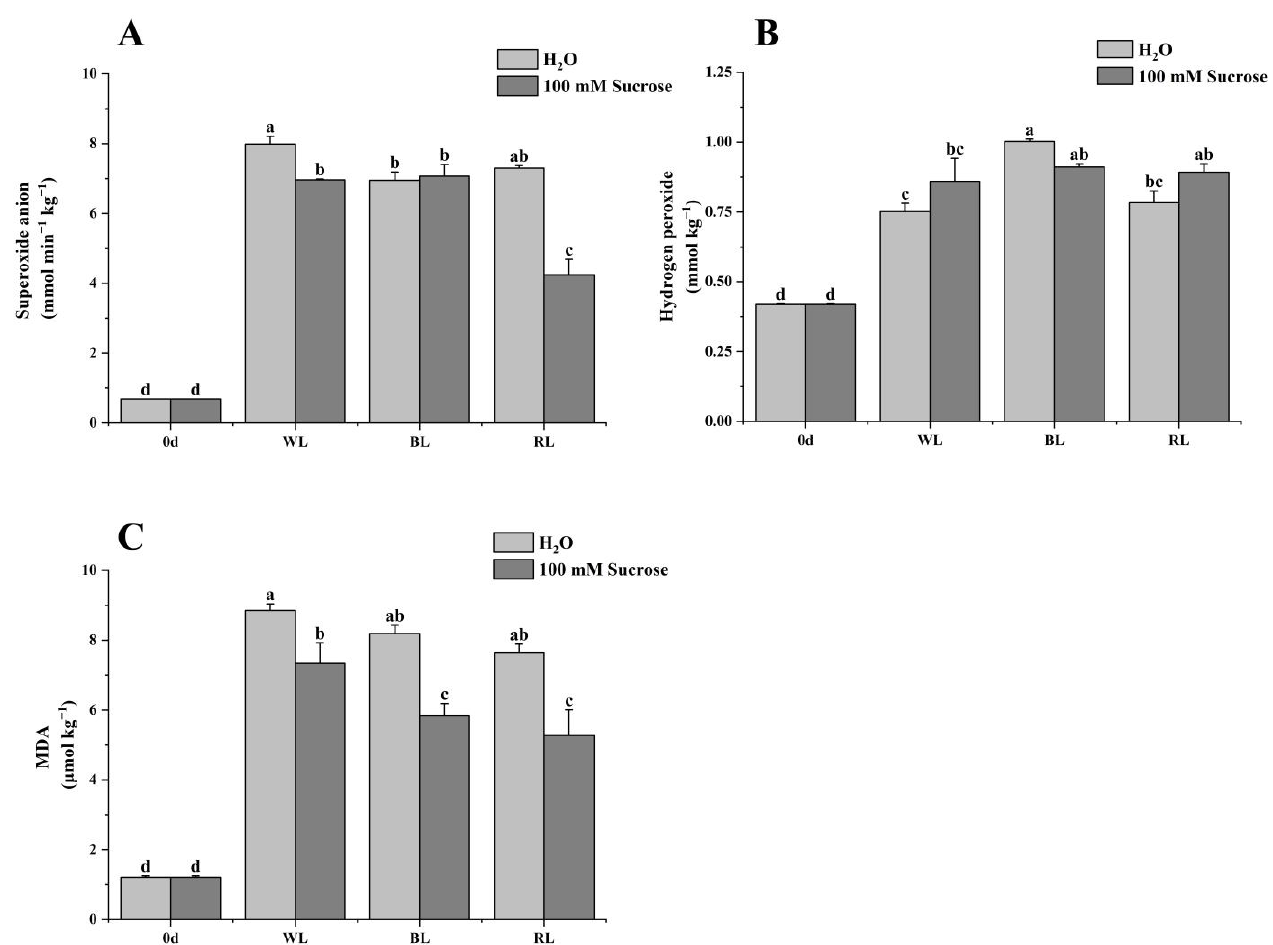
Figure 4. Effect of light quality and sucrose on superoxide anion ( A ), hydrogen peroxide ( B ), and MDA ( C ). Data represent the means ± standard error ( n = 3). Different lowercase letters indicate the statistically significant difference of the mean values based on one-way analysis of variance (ANOVA) followed by Duncan's multiple range test ( p ≤ 0.05).